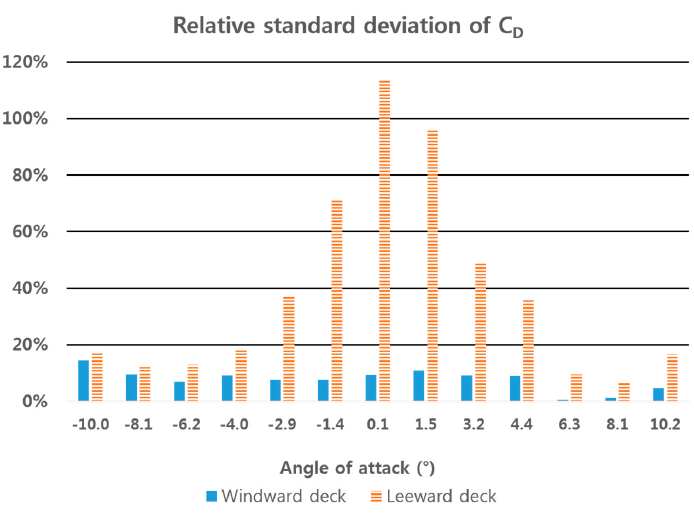
Figure 15. Variation of the C D relative standard deviation of each deck with respect to AoA.